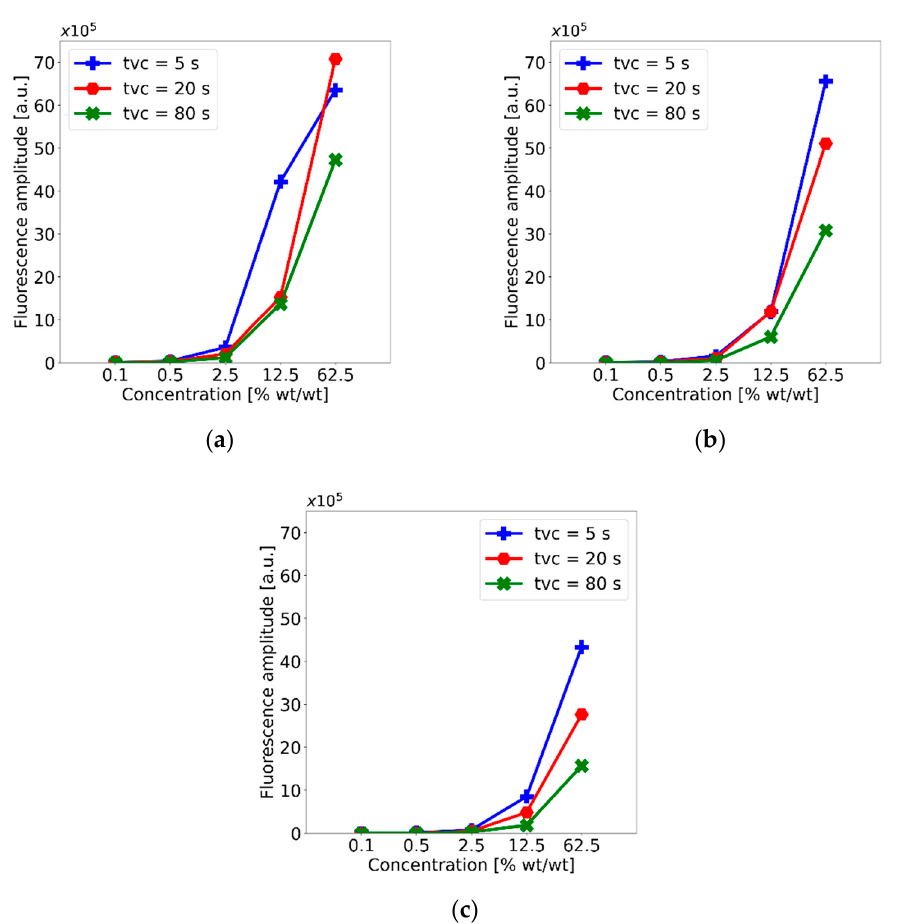
Figure 10. Variation in fluorescence peak intensity (625 nm) for different phosphor concentrations of the PDMS-GOS:Eu membranes fabricated using spin-coating velocities of ( a ) 1000 rpm, ( b ) 2000 rpm and ( c ) 4000 rpm.